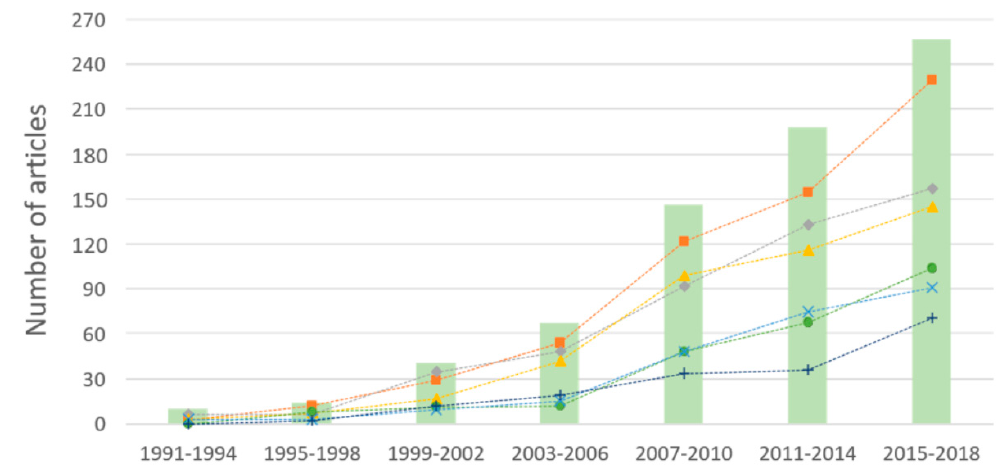
Figure 1. Evolution of the total number of articles (bars) and number of articles containing keywords related to specific subjects ( ■ : analytical techniques, ♦ : chemometrics, ▲ : chemical compounds, ● : authenticity and quality, × : geographical origin, + : varietal origin) between 1991 and 2018.